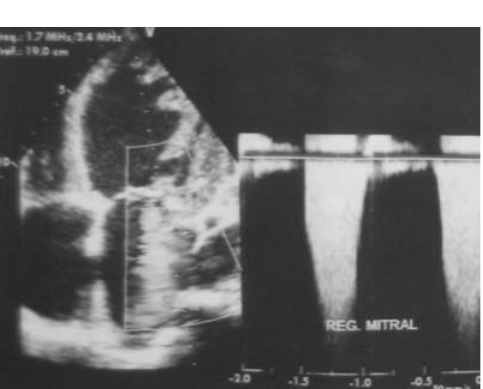
Figure 1 - Eletrocardiography at admission